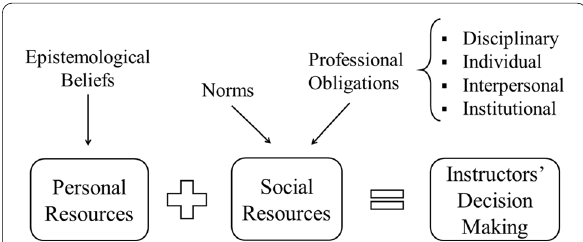
Fig. 1 Diagram of contributors to instructional decision-making in the Theory of Practical Rationality (Chazan et al., 2016; Herbst & Chazan,